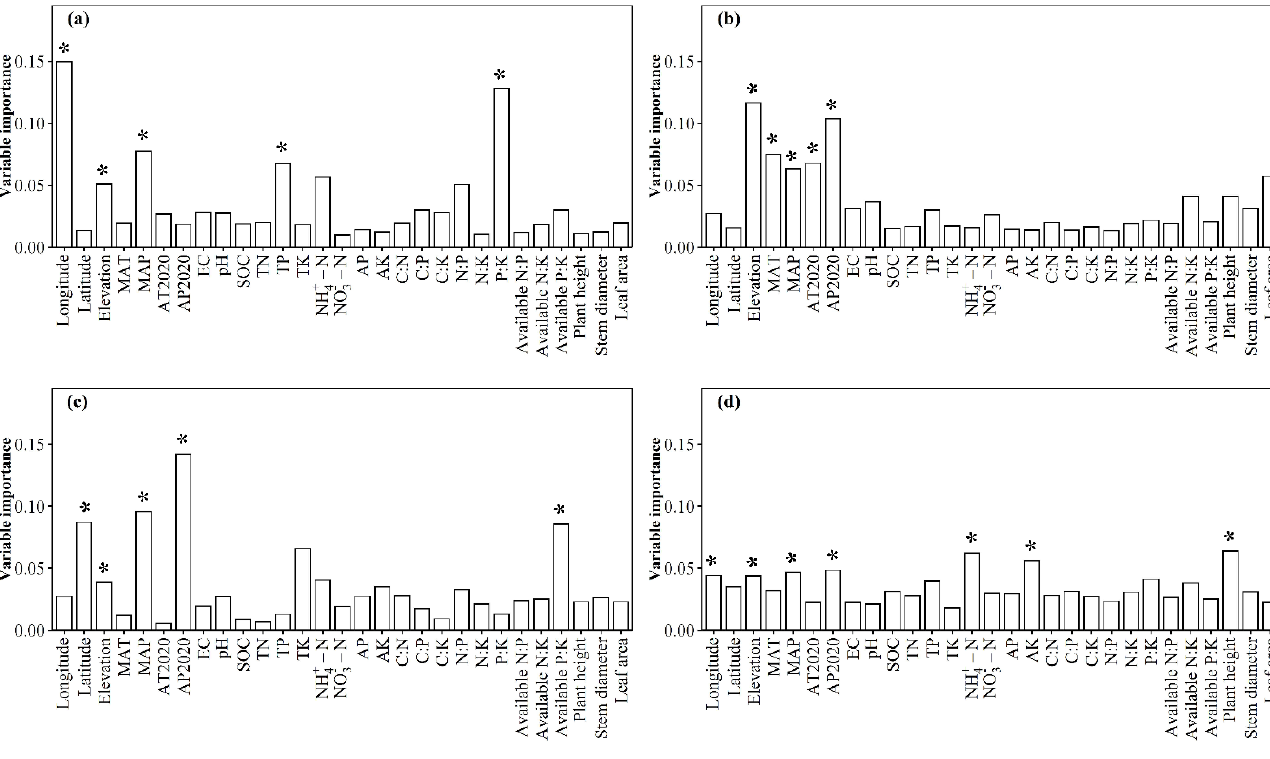
Figure 3. Relative impacts of environmental variables on ( a , b ) Faith’s phylogenetic diversity (PD), and ( c , d ) mean nearest taxon distance (MNTD) for ( a , c ) topsoil and ( b , d ) subtopsoil, respectively. The * above the bar indicated this variable had a significant influence on phylogenetic α -diversity.